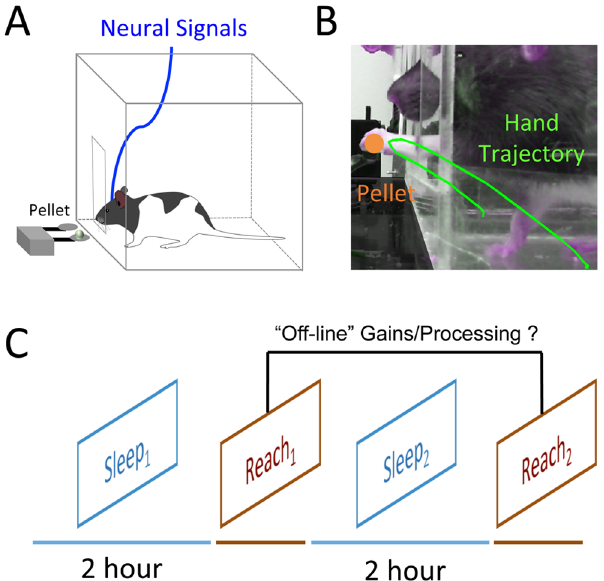
Fig 1. Behavioral paradigm. (A) Illustration of behavioral task [33], in which animals are required to reach through a narrow slit to grasp and retrieve a pellet into their cage. (B) Picture of animals grasping a pellet. Green line shows an example reach trajectory from which kinematic analyses are performed. (C) Overall behavioral/recording paradigm involved four blocks: a 2-h block of spontaneous recording (Sleep 1 ), a block of skilled motor training (Reach 1 ), another 2-h block of spontaneous recording (Sleep 2 ), followed by a final reach block (Reach 2